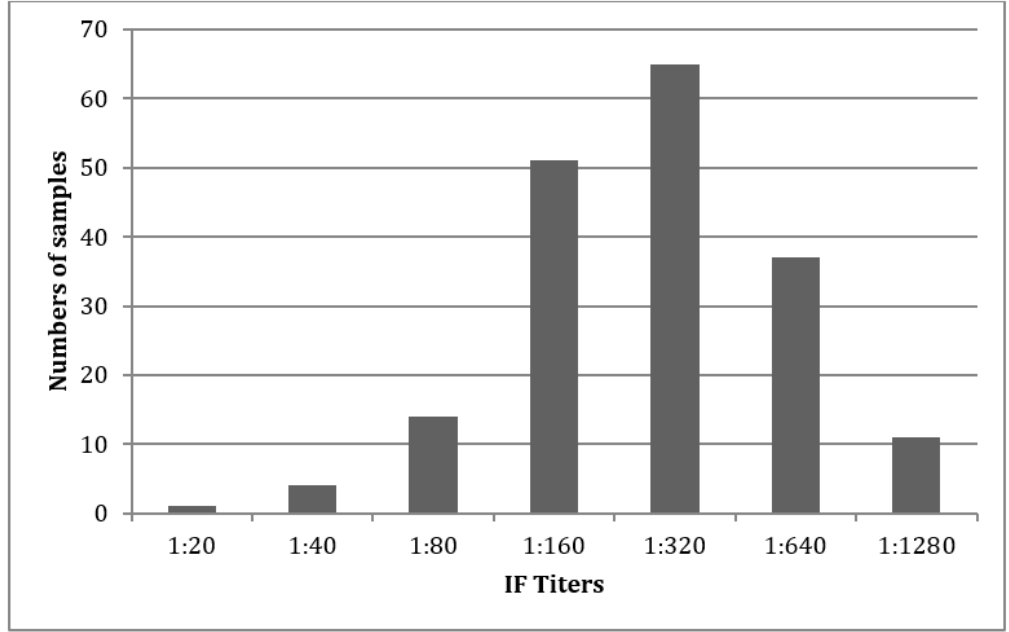
7 of 15 Table 2. Serologic test results. PPV: positive predictive value, NPV: negative predictive value, FNR: false negative rate, FPR: false positive rate. Serology (At Least 2 Tests Positive)